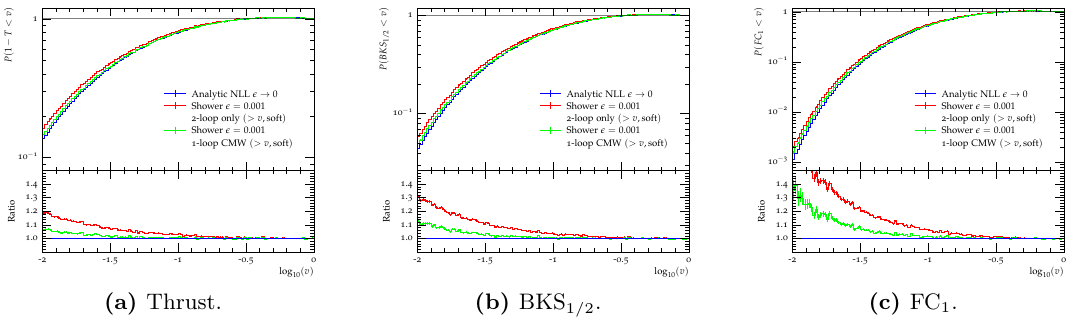
Figure 4 . E(cid:11)ects of replacing 2-loop CMW running of (cid:11) The red line is computed without the CMW scheme, while the green line is computed by using the CMW scheme at